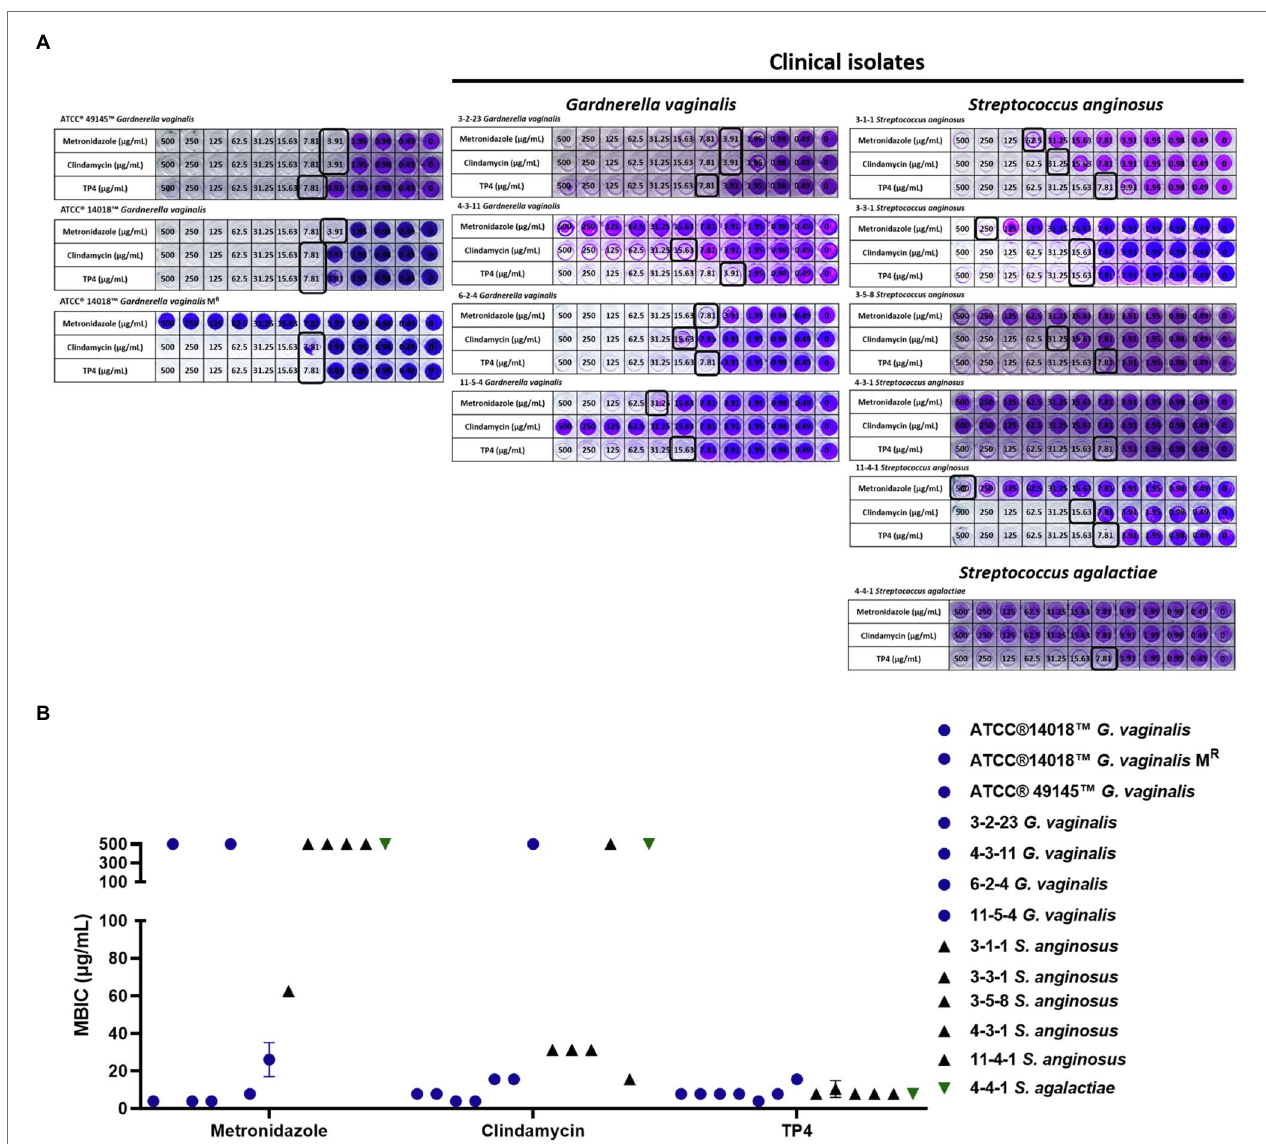
FIGURE 4 | Inhibitory effect of TP4 and antibiotics on BV-associated bacteria biofilm formation. Biofilms formed by BV-associated bacteria were tested with various concentrations of the TP4 and antibiotics. (A) The biofilm cells were stained with crystal violet; a representative result from three replicates. Black frame representative Minimal biofilm inhibitory concentration (MBIC). (B) Quantification of the MBIC was performed in three individual experiments. The y-axis 500 represents MBIC ≥ 500 μ g/ml. All values represent the mean ± SD of three individual